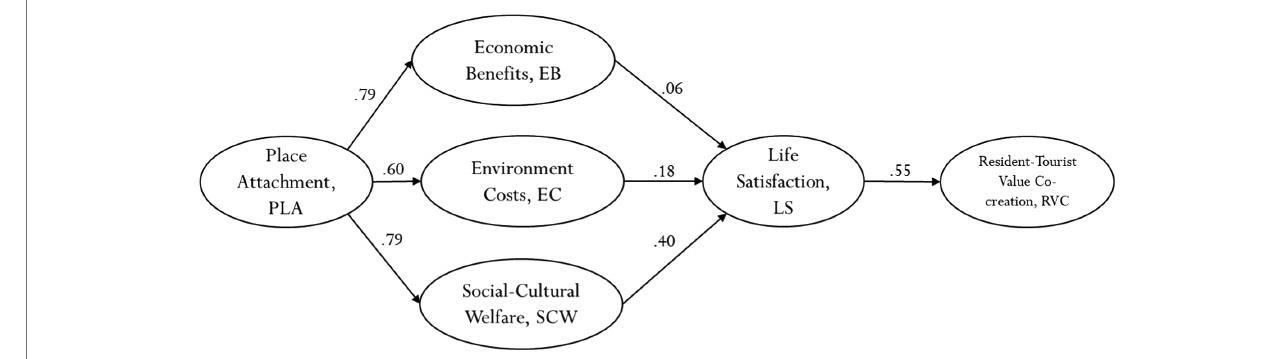
FIGURE 3 | Statistical model analysis.